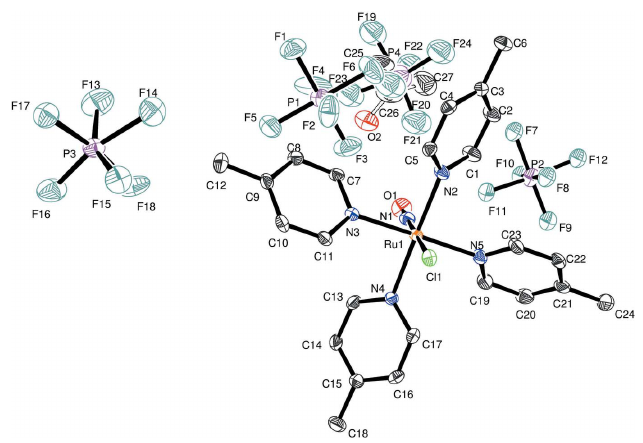
Figure 1 The structures of the molecular entities in the title salt with the atom numbering. Displacement ellipsoids are drawn at the 50% probability level. The acetone molecule (open bond) is disordered with one hexafluoridophosphate anion. Hydrogen atoms are omitted for